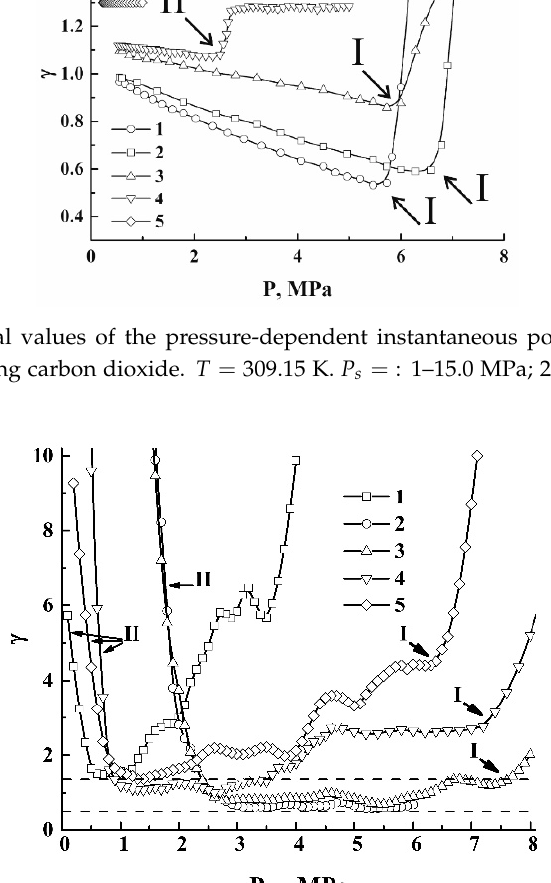
Figure 12. The smoothed dependencies γ ( P ext ) in the case of a quasi-adiabatic foaming. The horizontal dashed lines mark the interval of theoretical values for carbon dioxide (see Figure 11).